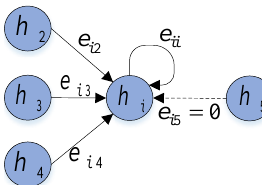
Figure 2. The illustration of message passing mechanism in directed spatial graph.